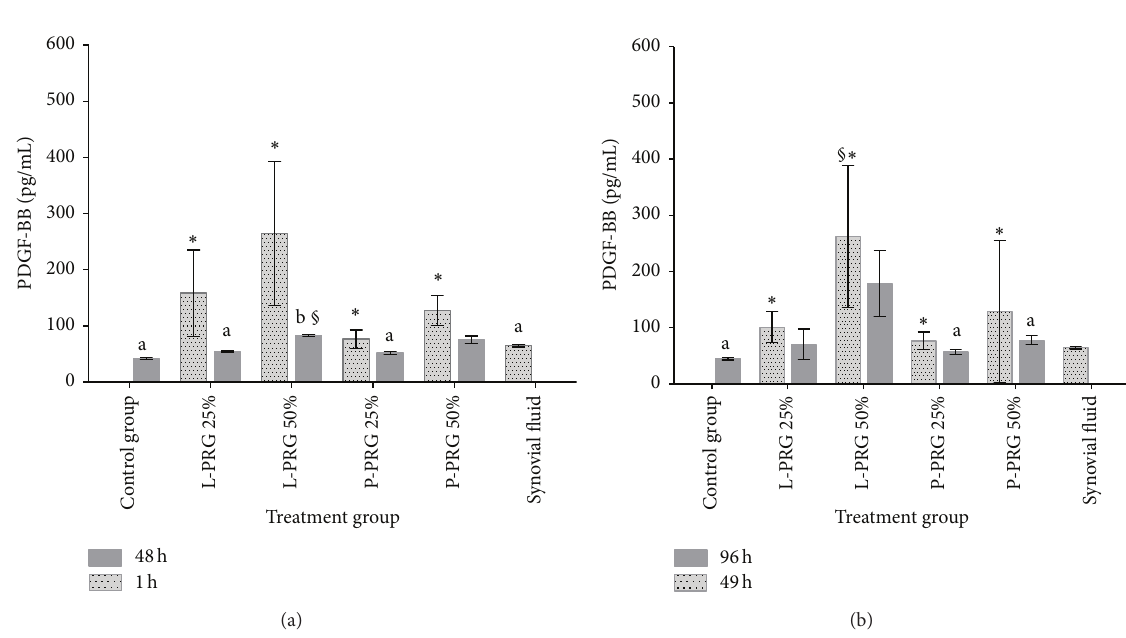
Figure 2: (a) a-b Lowercase letters denote significant ( 𝑃 < 0.05 ) differences between groups in the same column by Tukey test at 48 h. Significantly different with a: L-PRG 50% and P-PRG 50% and b: synovial fluid (SF). (b) a Lowercase letters denote significant ( 𝑃 < 0.05 ) differences between groups in the same column by Tukey test at 96 h. Significantly different with a: L-PRG 50%. ∗ Significant differences ( 𝑃 < 0.01 ) between the same variable at 1h and 48h and at 49 h and 96 by 𝑡 -paired test. § ∗ Significant differences ( 𝑃 < 0.05 ) between the same variable at 48 and 96 h by Tukey